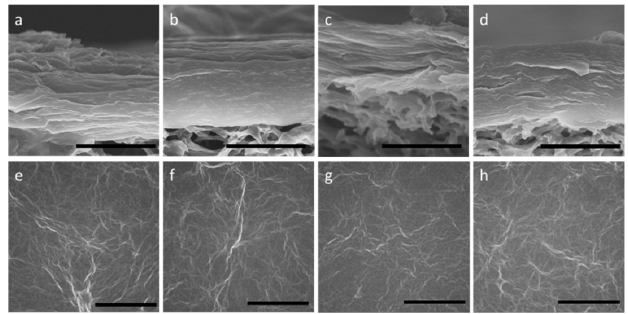
Figure 2. SEM images of cross-sections and overviews of the unmodified GO membrane ( a ) and ( e ) and GO membranes modified with TEOA (GO-TEOA membranes) fabricated with TEOA/GO = 0.5 ( b ) and ( f ); 1 ( c ) and ( g ) and 2 ( d ) and ( h ). Scale bar: 1 µm in ( a – d ); 10 µm in ( e – h ).